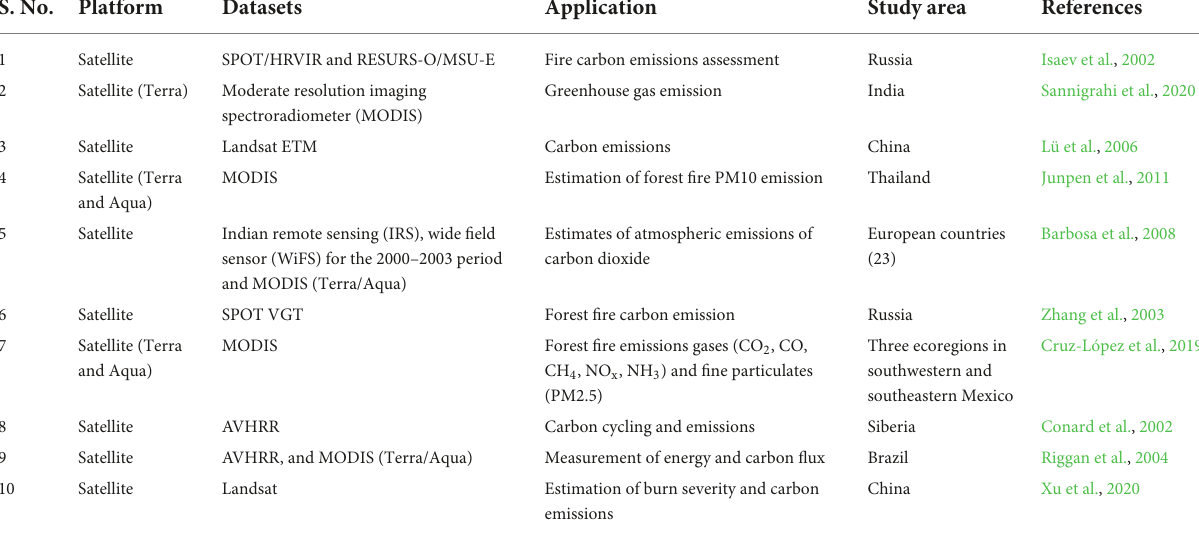
TABLE 1 Application of remote sensing (RS) and geographic information system (GIS) in fire emission monitoring. S. No.